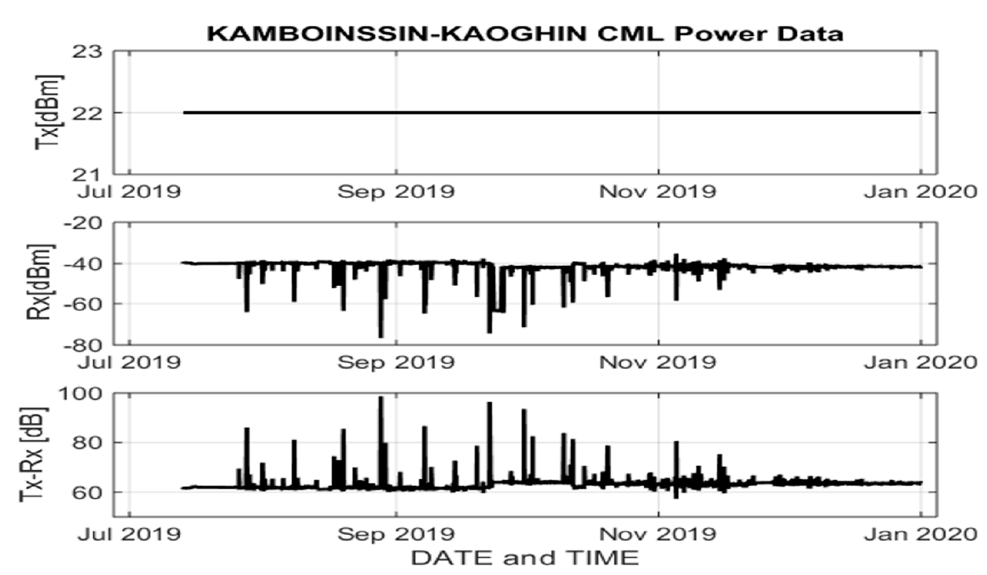
Figure 7. Transmitted power, received power, and attenuation of the KAMBOINSSIN-KAOGHIN link.